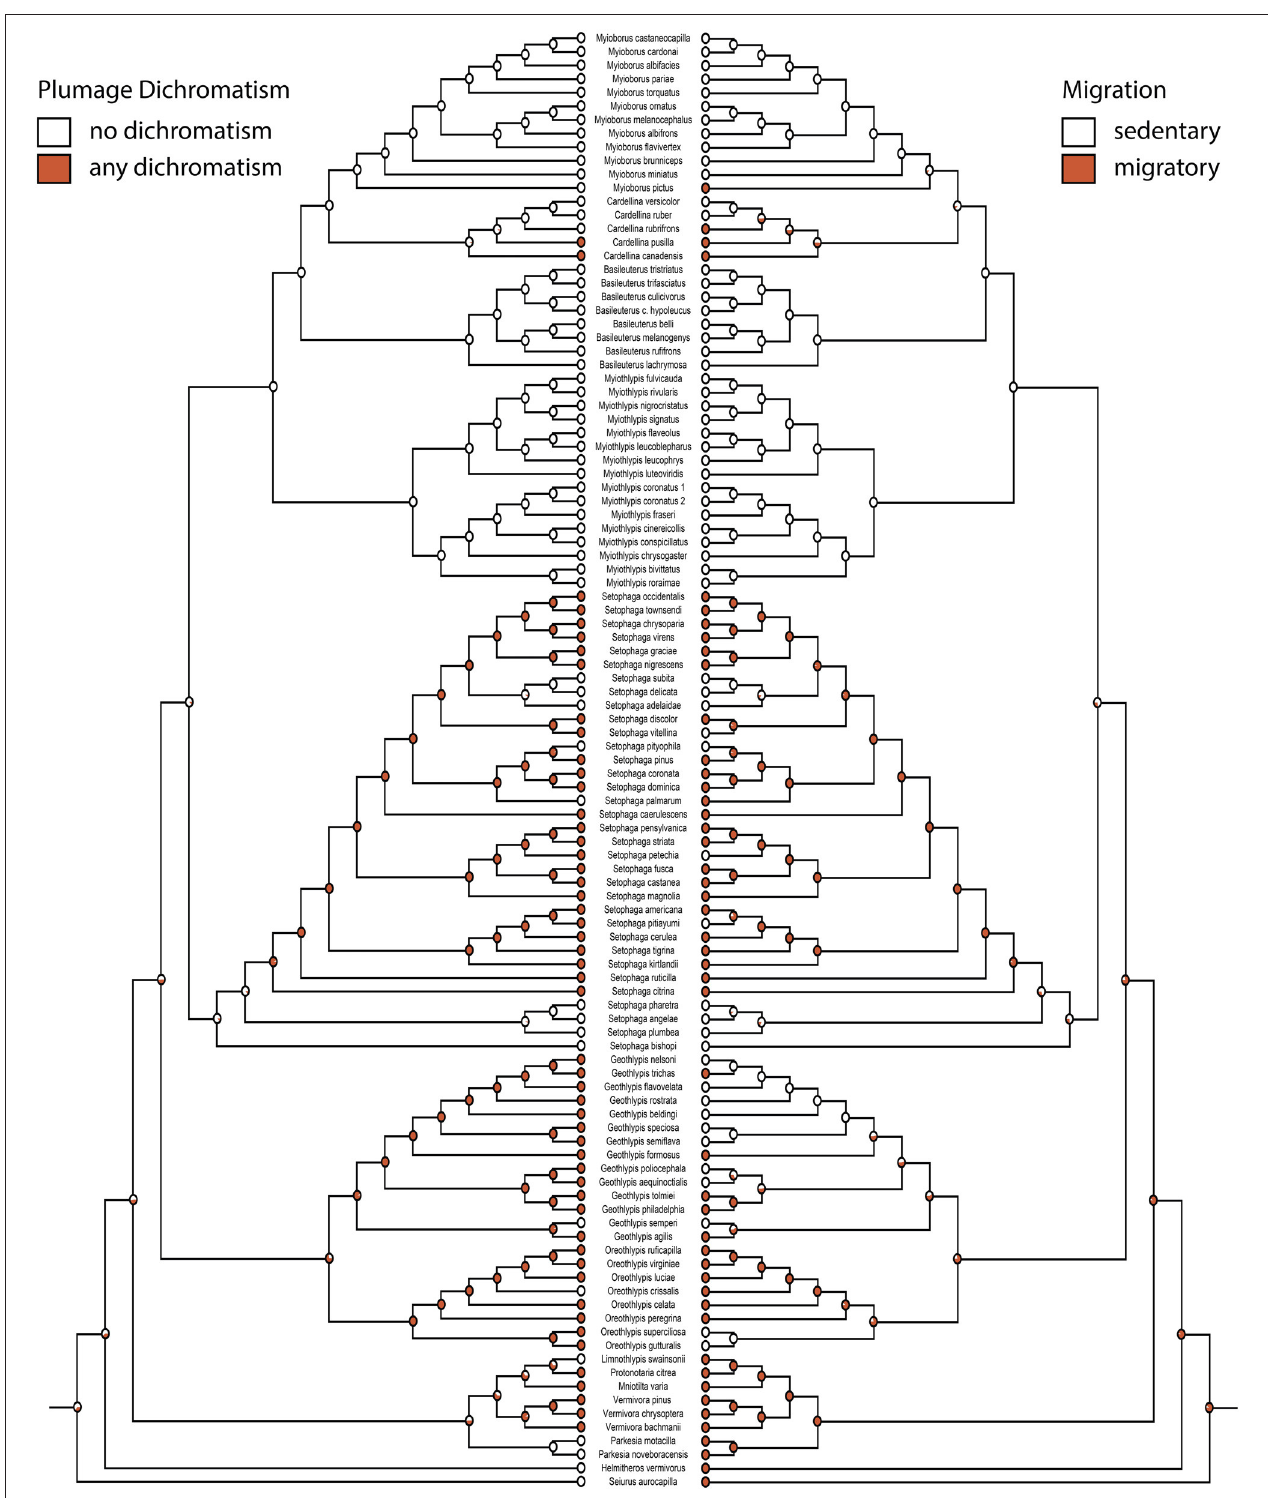
FIGURE 3 | Any plumage dichromatism (mk1, log likelihood: − 56.91) on the left mirrored with migration (mk1, log likelihood: − 46.81) on the right. Red circles are dichromatic or migratory, white circles are not. Pie charts indicate proportional likelihoods.